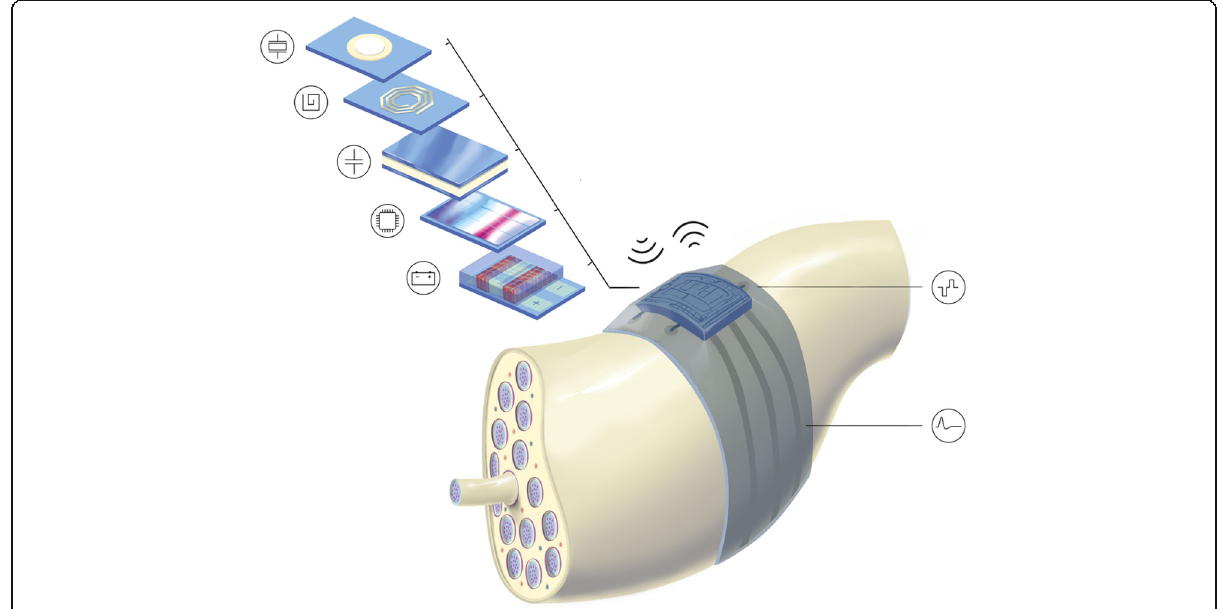
Fig. 1 Artistic impression of a flexible BEm for accessing the peripheral nerves (concept). The BEm features a compact layout, with all components required for its wireless closed-loop operation integrated on the device. Small and thin ASICs connect to electrodes and give the system its intelligence. They receive and store energy, communicate with the outside world, process the acquired signals, and deliver the personalised therapy in the form of electrical